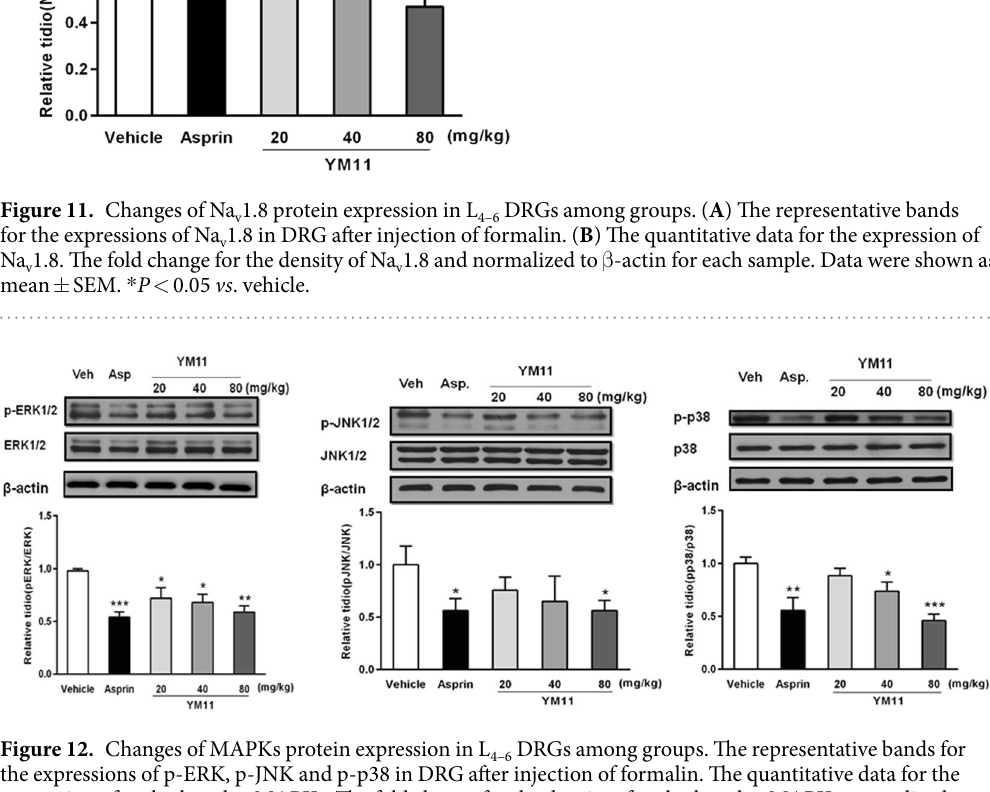
L4–6 DRG neurons after YM 11 treatment.